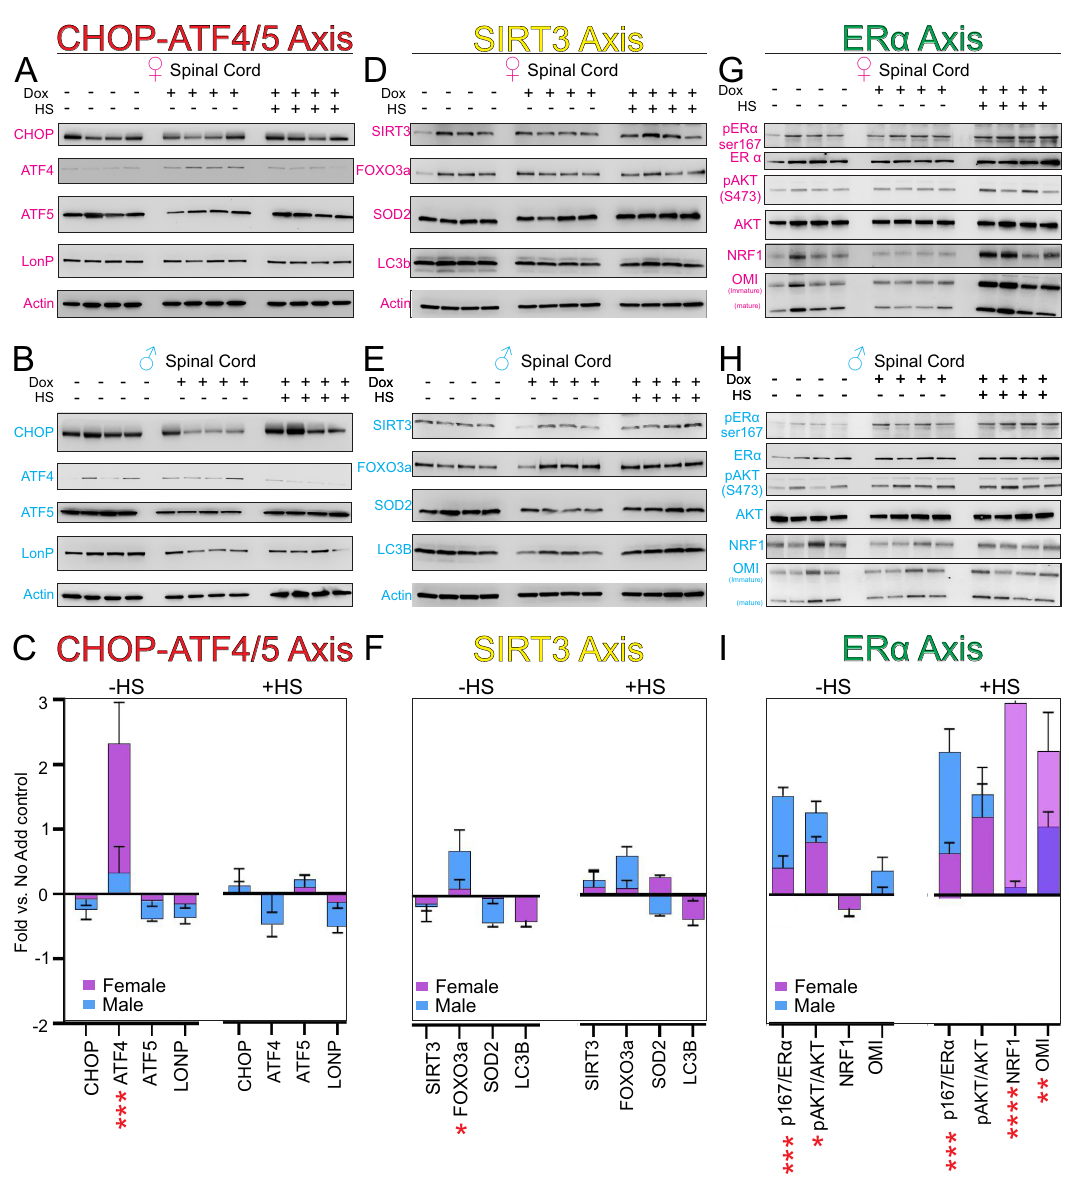
Figure 2. Doxycycline activates the ERα axis of the UPR mt in the spinal cord. ( A ) Western blot of the indicated markers of the CHOP-ATF4/ATF5 axis of the UPR mt in the spinal cord of female mice (n = 4) untreated or treated with doxycycline (Dox) alone or with heat shock (HS). ( B ) Western blot of the indicated markers of the CHOP-ATF4/ATF5 axis of the UPR mt in the spinal cord of male mice (n = 4) untreated or treated with doxycycline (Dox) alone or with heat shock (HS). ( C ) Quantification of ( A ) and ( B ). Values were normalized to actin. Graphs indicate change relative to the untreated control. ( D ) Western blot of the indicated markers of the SIRT3 axis of the UPR mt in the spinal cord of female mice (n = 4) untreated or treated with doxycycline (Dox) alone or with heat shock (HS). ( E ) Western blot of the indicated markers of the SIRT3 axis of the UPR mt in the spinal cord of male mice (n = 4) untreated or treated with doxycycline (Dox) alone or with heat shock (HS). ( F ) Quantification of ( D ) and ( E ). Values were normalized to actin. Graphs indicate change relative to the untreated control. ( G ) Western blot of the indicated markers of the ERα axis of the UPR mt in the spinal cord of female mice (n = 4) untreated or treated with doxycycline (Dox) alone or with heat shock (HS). ( H ) Western blot of the indicated markers of the ERα axis of the UPR mt in the spinal cord of male mice (n = 4) untreated or treated with doxycycline (Dox) alone or with heat shock (HS). ( I ) Quantification of ( G ) and ( H ). Values were normalized to actin. Graphs indicate change relative to the untreated control. * or **, indicates p < 0.05 or p < 0.005 comparing females to males. For western blots in all panels, samples were run on the same gel in the indicated order with an empty well between groups to facilitate visualization and none of the images were